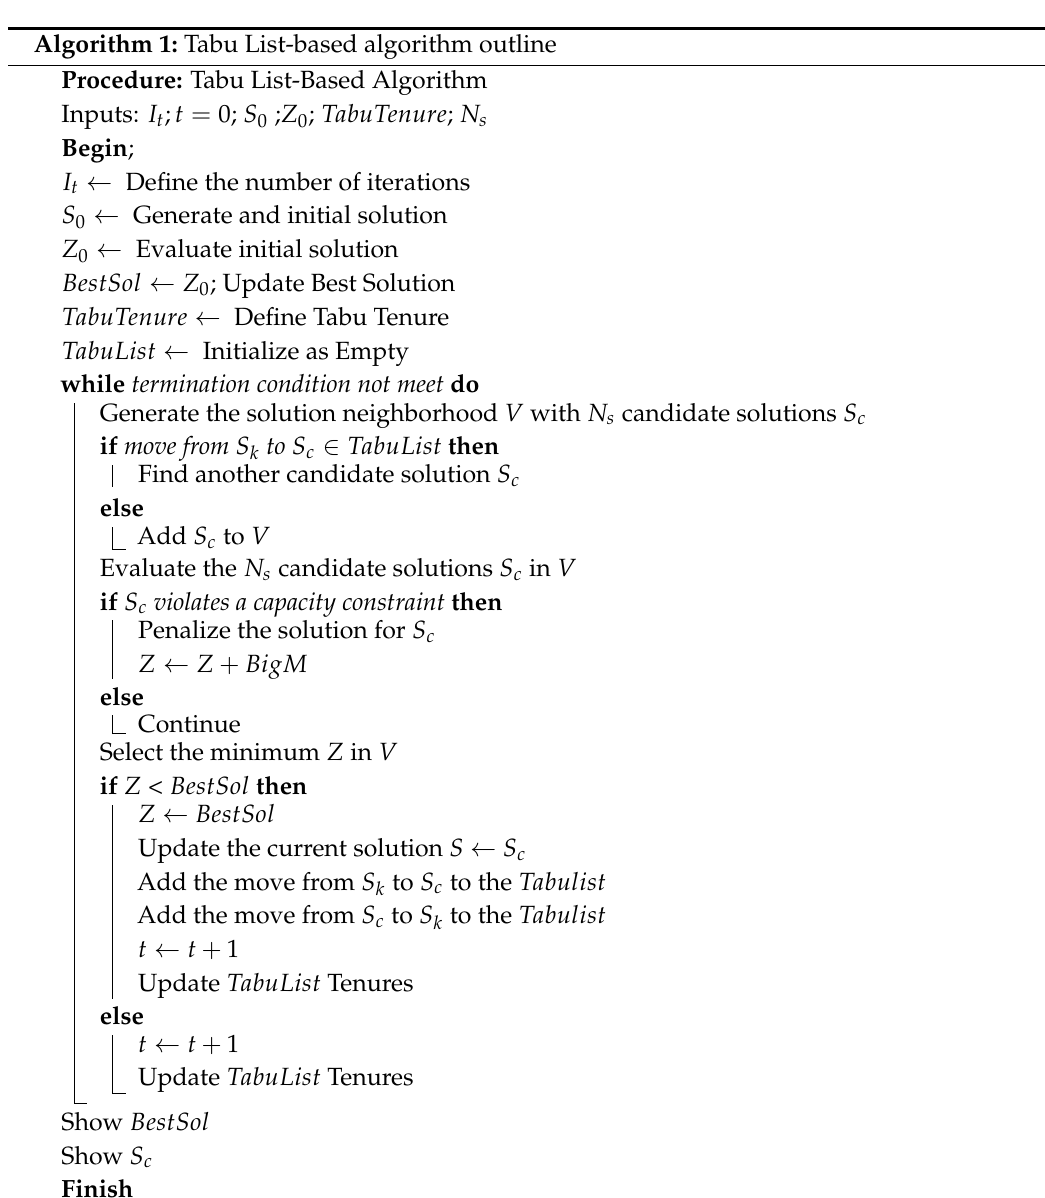
Algorithm 1: Tabu List-based algorithm outline Procedure: Tabu List-Based